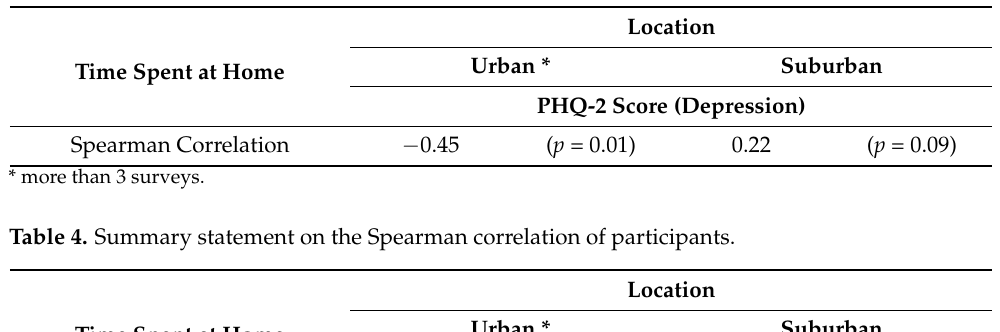
Time Spent at Home